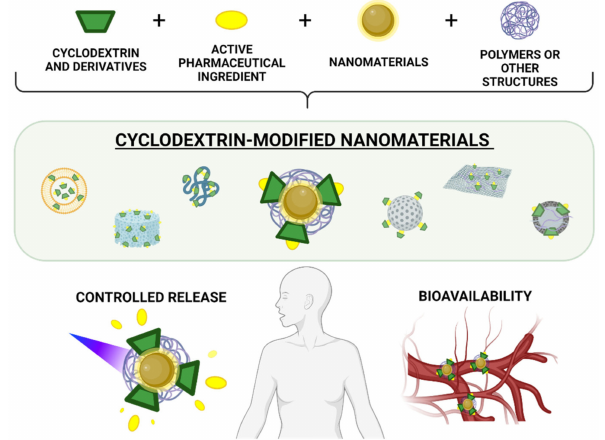
Figure 1. General scheme of the construction of nanosystems based on CD, polymers, and nanomate- rials for their use in controlled release and enhanced bioavailability. Created with